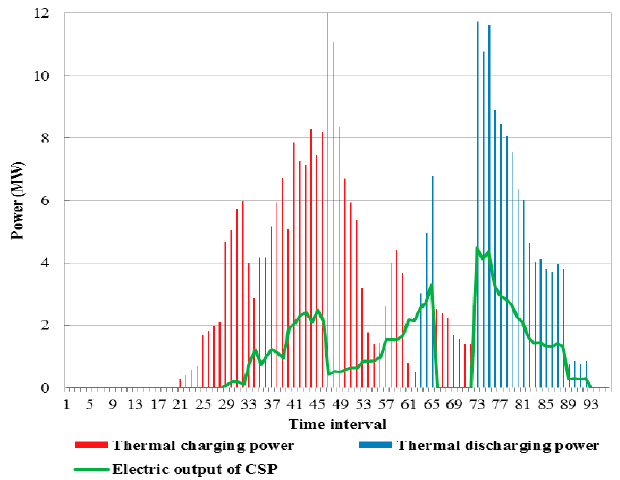
Figure 6. Thermal charging/discharging power and the electrical output of a CSP unit on a typical summer day.